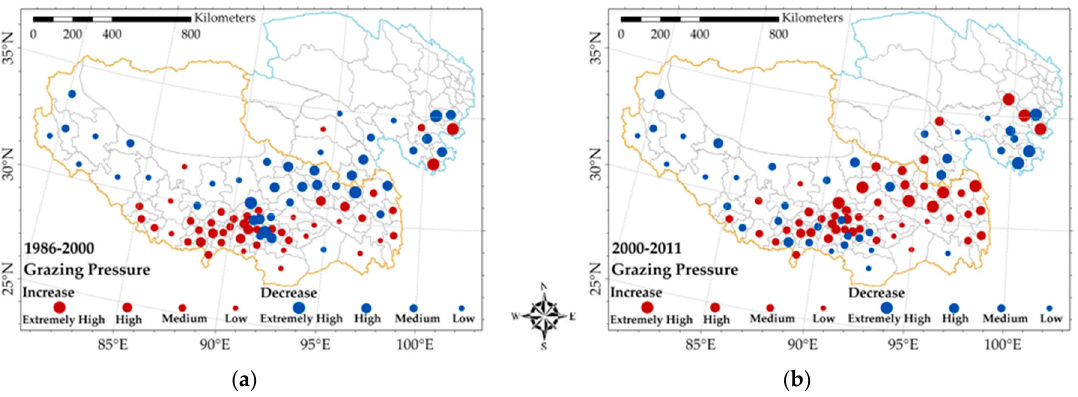
Figure A1. The multi-year average grazing pressure and the temporal trend ( a ) During 1986–2000; ( b ) During 2000–2011 at a county scale.